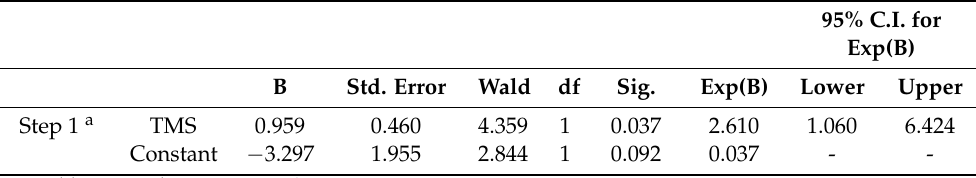
Table 22. Top management support: regression analysis for